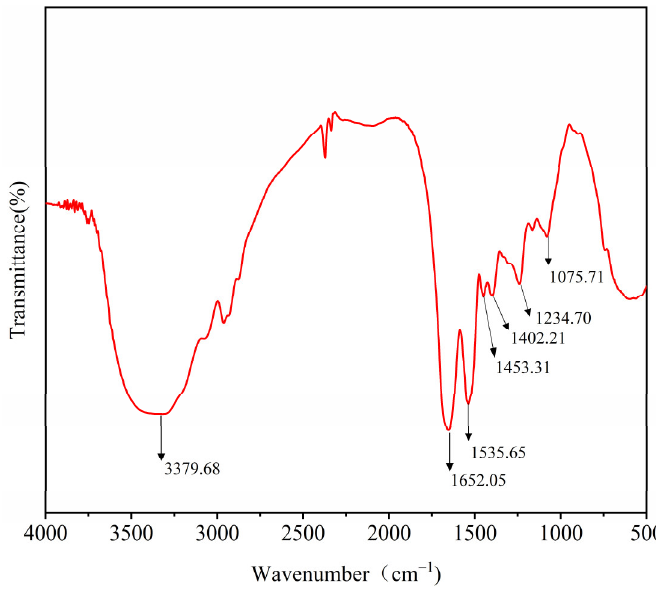
Figure 6. Infrared spectrum of lysozyme from SDEW. Table 4. Secondary structure analysis of salted duck egg white lysozyme, including relative content of the main form of the secondary structure of salted duck egg white lysozyme.